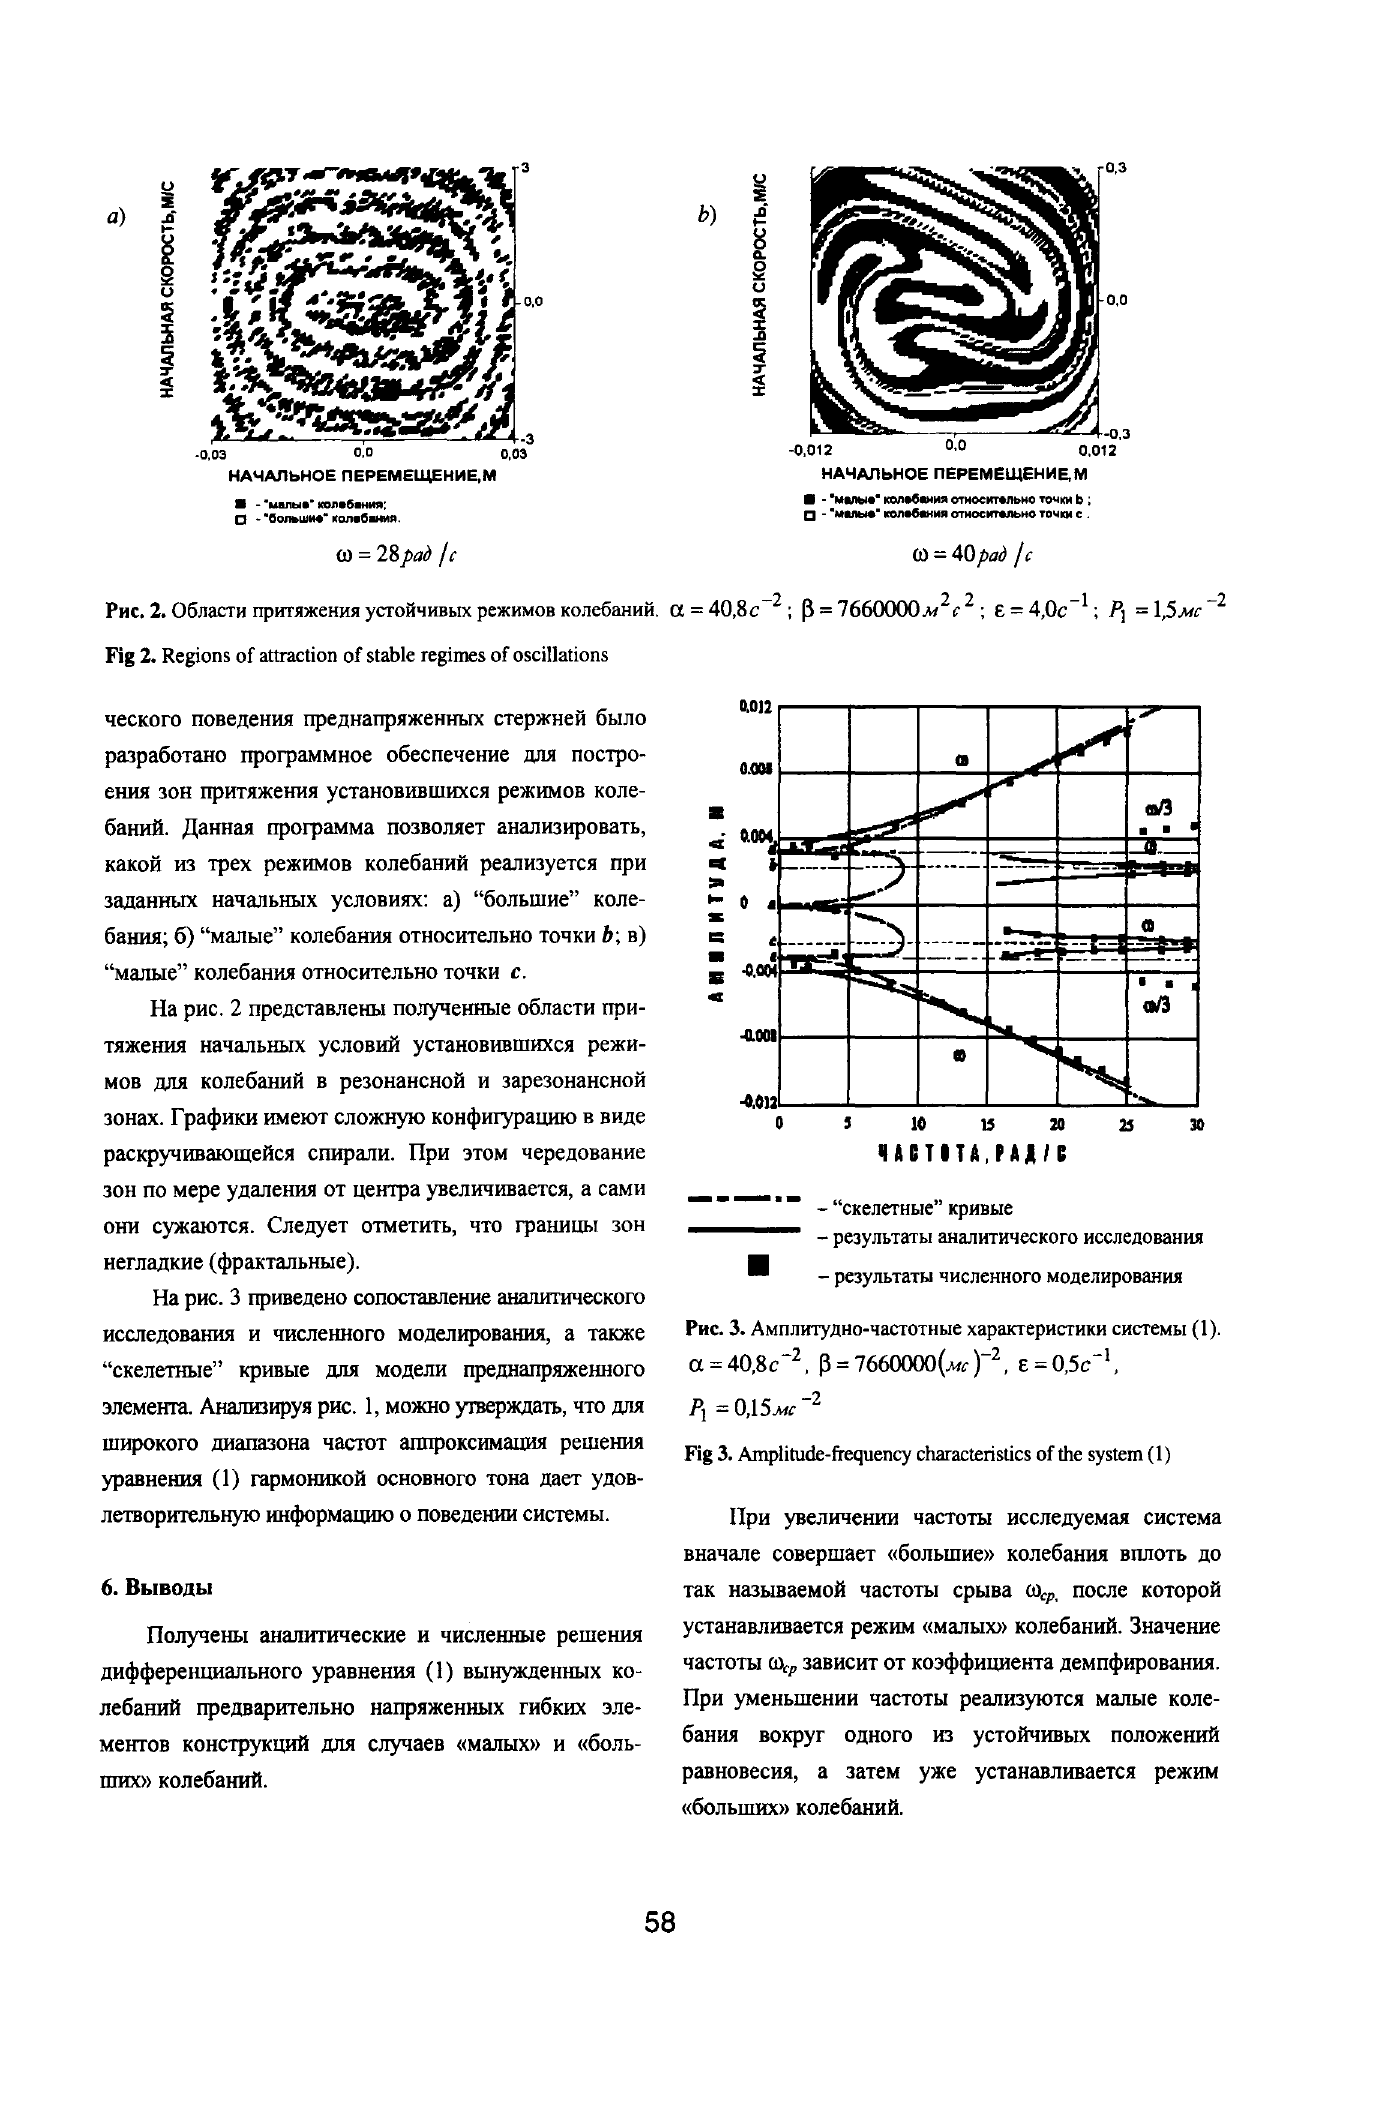
Puc. 2. 05nacnt npHTJIJKeHHJI ycroii'IHBbiX pelKHMOB Kone5rumii. a= 40,8c - 2 ; ~ = 7660000M 2 c 2 ; £ = 4,0c -l ; P 1 = 1,5Mc - 2